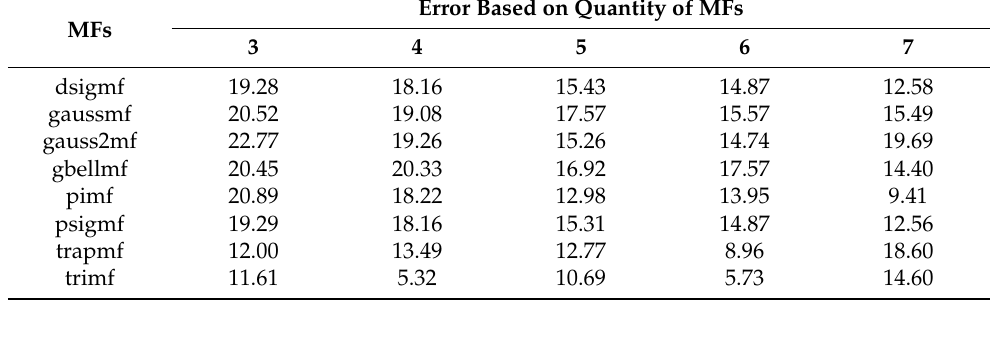
Table 3. Training error in ANFIS based on MFs.